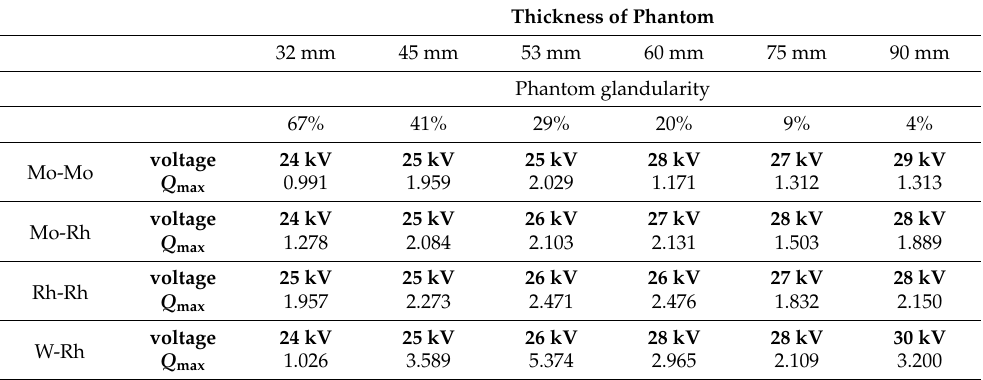
Figure 6. Q parameter as a function of high voltage for the 75 mm-thick breast and various anode–filter combinations. The points from the simulation are connected with a line. Table 5. Optimal voltages on the X-ray tube in kV for breasts of various structures and the corre- sponding Q max (maximum values of parameter Q ) for the selenium image